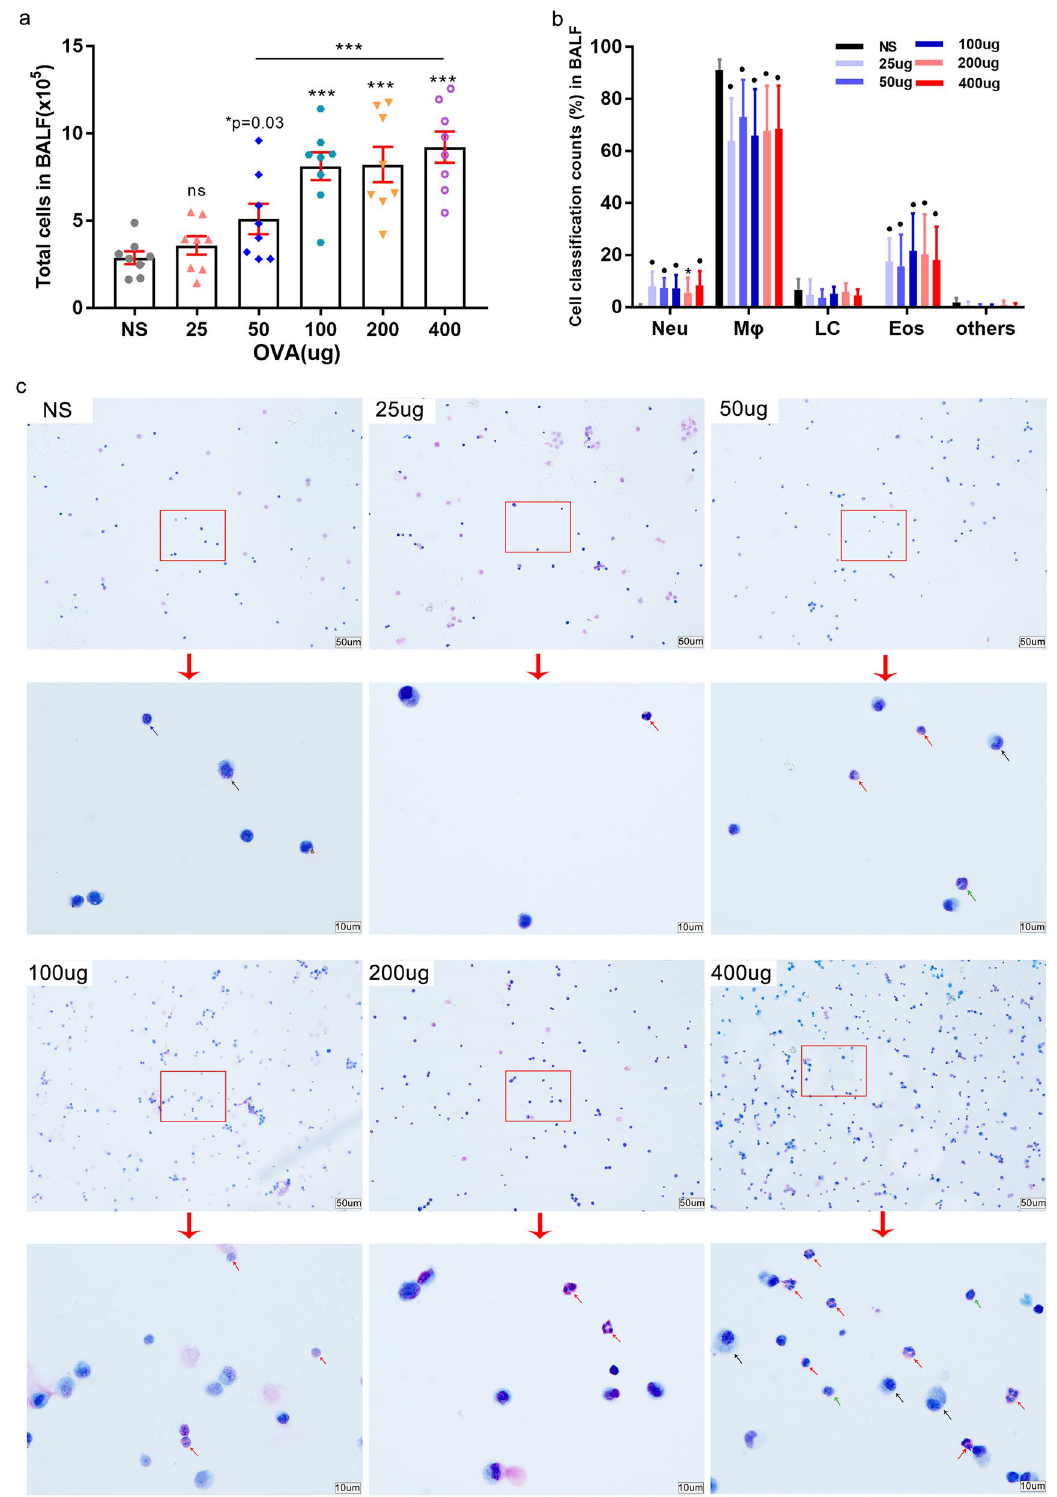
Figure 3. Total cells count and cell classification in BALF after OVA administration. ( a–c ) Bronchoalveolar lavage fluid (BALF) from mice was obtained after airway responsiveness determination. ( a ) Total cells count in BALF were measured using a Neubauer hemocytometer under 200 × microscope. ( b ) Giemsa-Wright stained cells in the BALF were ascribed to distinct categories and counted using a 100 × microscope objective (oil immersion lens) by Wright-Giemsa staining. ( c ) Representative photographs of BALF cells after Wright–Giemsa staining (up, 200 × and down, 1000 × magnifications). Arrows’ colors represent different cells types (green- neutrophils; black-monocytes and macrophages; blue-lymphocytes, red-eosinophils). (25 µg OVA, n = 5; other groups, n ≥ 9. * P ≤ 0.05; ** P < 0.01; *** P < 0.001; ns, no significance). The scale is indicated on the panel by the length of the box around the size in